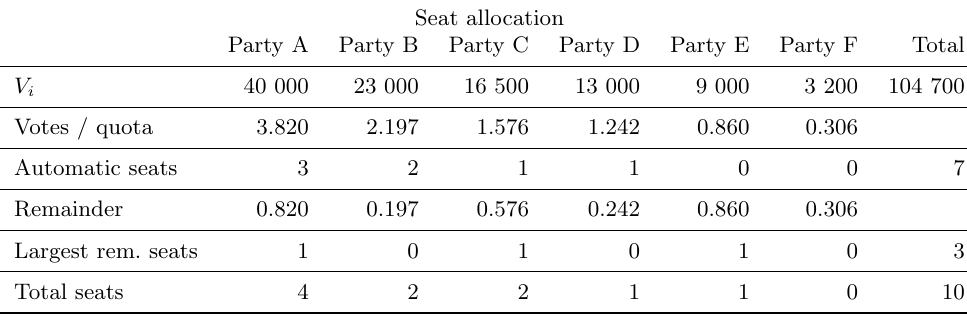
Table 4: Allocation of seats using the Hare quota. In this table 10 seats should be allocated, which implies a Hare quota of 10 470.